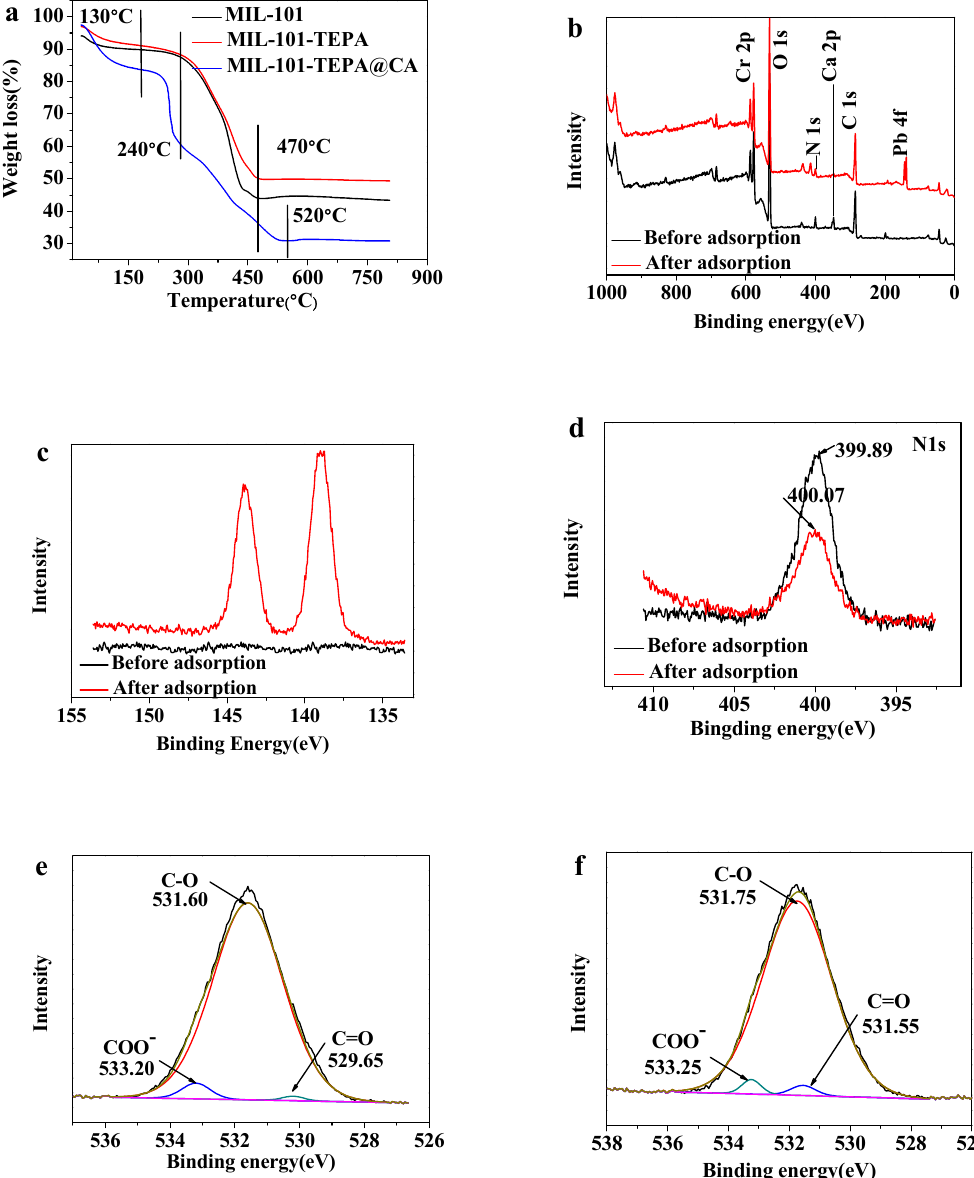
Figure 3. ( a ) Thermal analysis of MIL-101, MIL-101-TEPA, and MIL-101-TEPA@CA; XPS spectra of MIL-101-TEPA@CA before and after loading Pb(II): ( b ) wide-scan; ( c ) Pb 4 f ; and ( d ) N 1 s , C1 s spectra ( e ) before and ( f ) after ( e ) before and ( f ) after adsorption.